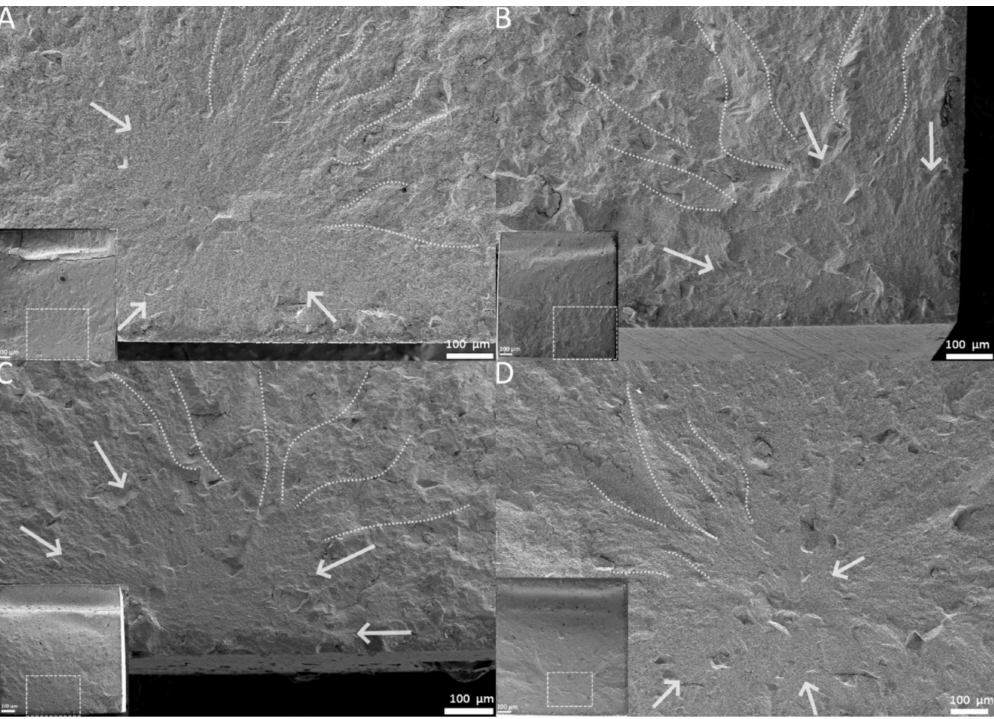
Figure 4. SEM images: ( A ) = sub-surface fracture origin, ISO-cure, step three aging; ( B ) = corner fracture origin, 10 s-cure, step one aging; ( C ) = edge fracture origin, 3 s-cure, step two aging; ( D ) = plain fracture without a distinct fracture origin, 10 s-cure, step three aging; lower left corner gives an overview over each specimen, dotted box shows the magnified area of the specimen; arrows identify parts of the fracture mirror, dotted lines mark Hackle lines.